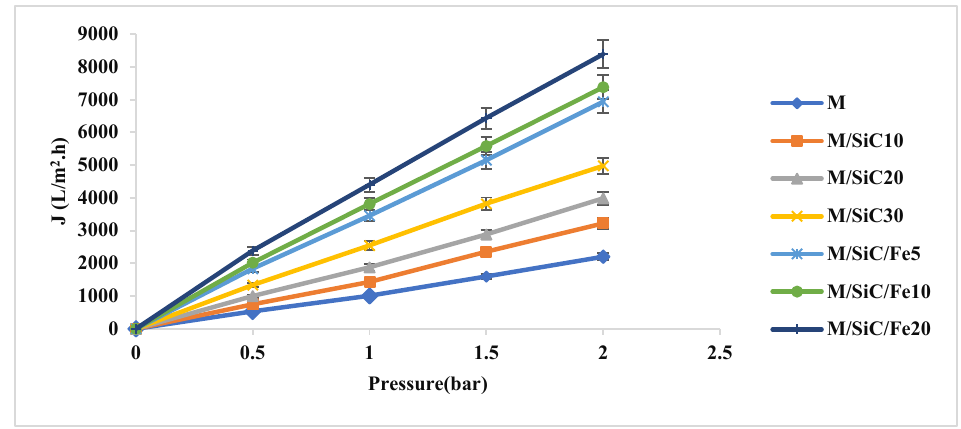
Figure 9. Effect of passing pressure on pure water flux for different microfiltration membranes .